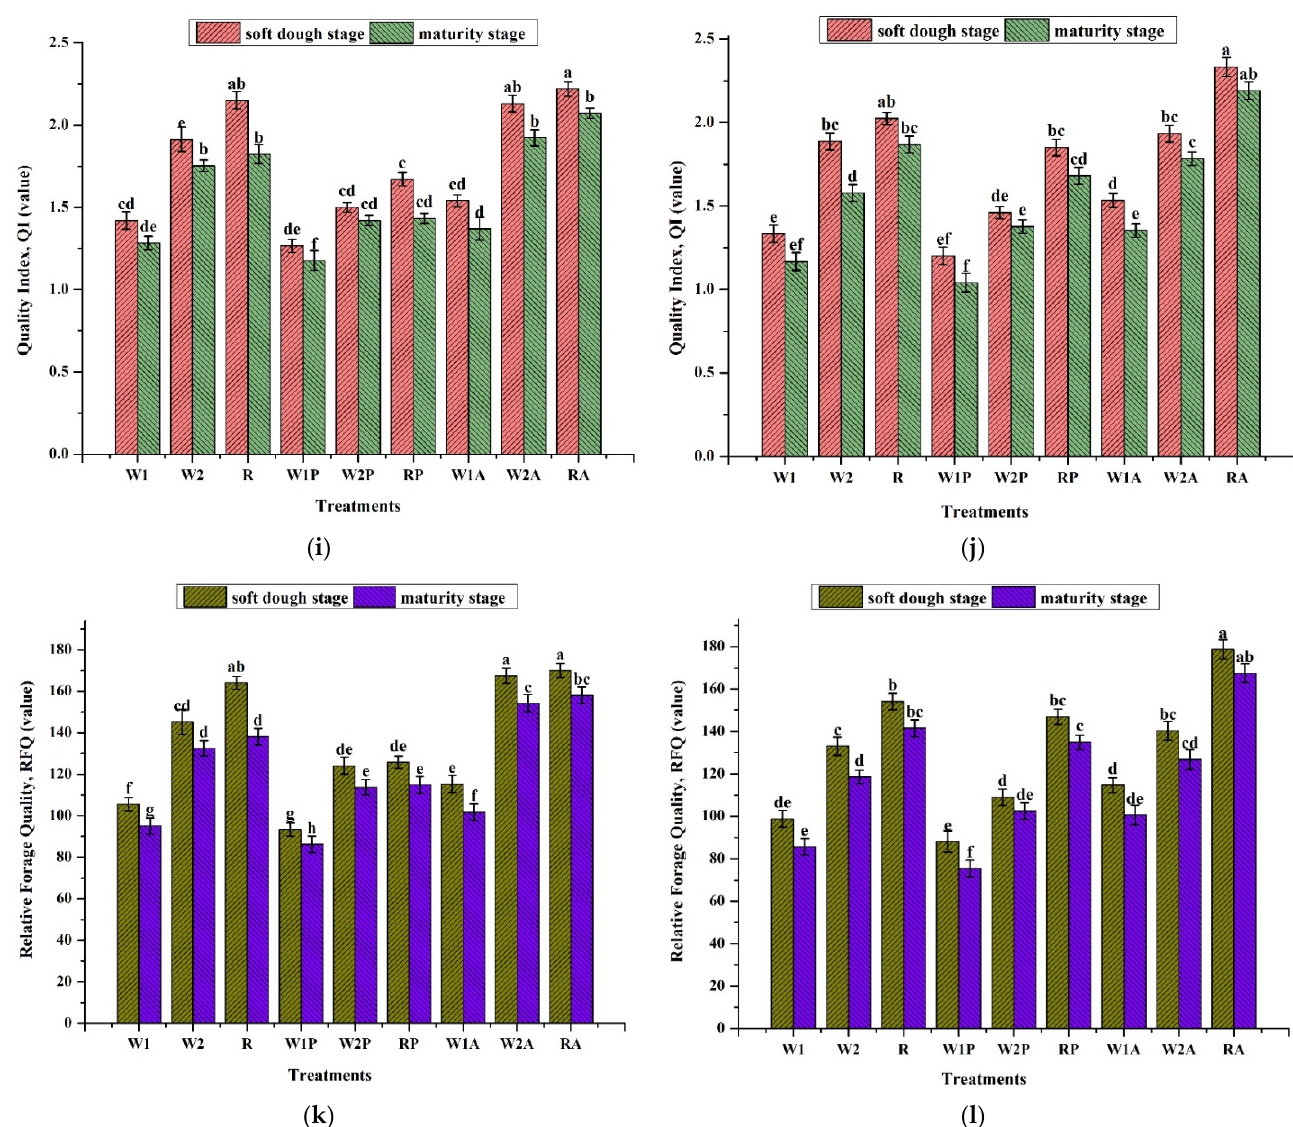
Figure 3. ( a ) Dry matter intake for 2020 growing season, ( b ) dry matter intake for 2021 growing season, ( c ) digestible dry matter for 2020 growing season, ( d ) digestible dry matter for 2021 growing season, ( e ) relative feed value for 2020 growing season, ( f ) relative feed value for 2021 growing season, ( g ) total digestible nutrient for 2020 growing season, ( h ) total digestible nutrient for 2021 growing season, ( i ) quality index for 2020 growing season, ( j ) quality index for 2021 growing season, ( k ) relative forage quality for 2020 growing season, ( l ) relative forage quality for 2021 growing season; treatments express as W1: sole cropping of Xiaoyan 17 wheat cultivar, W2: sole cropping of Biaomai 9 wheat cultivar, R: mono-cropping ryegrass cultivar, W1P: Xiaoyan 17 and pea mixed cropping, W2P: Biaomai 9 and pea mixed cropping, RP: ryegrass and pea mixed cropping, W1A: Xiaoyan 17 and alfalfa mixed cropping, W2A: Biaomai 9 and alfalfa mixed cropping, and RA: ryegrass and alfalfa mixed cropping. The error bars are the standard error of the mean. Different letters mean there are significant differences between the treatments at p < 0.05.